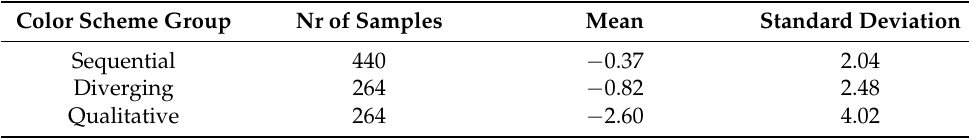
Table 4. Descriptive statistics of the error for the color scheme group. Color Scheme